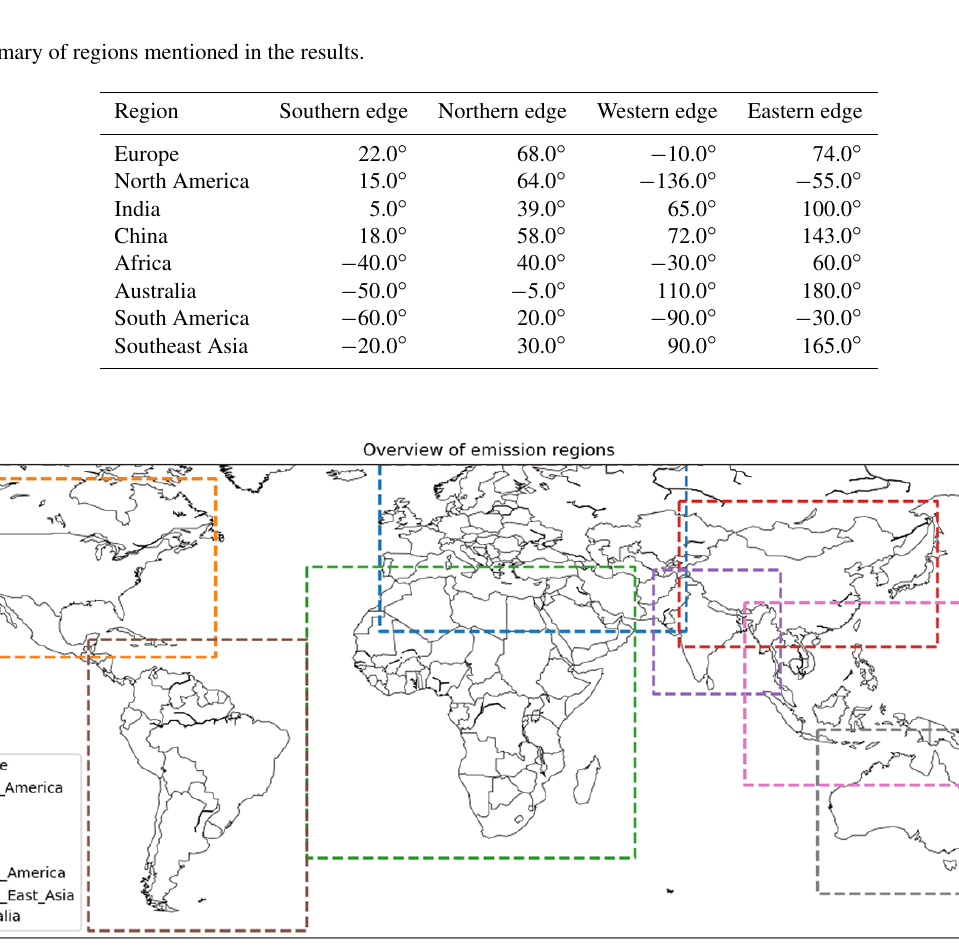
Figure F1. Overview of the emission